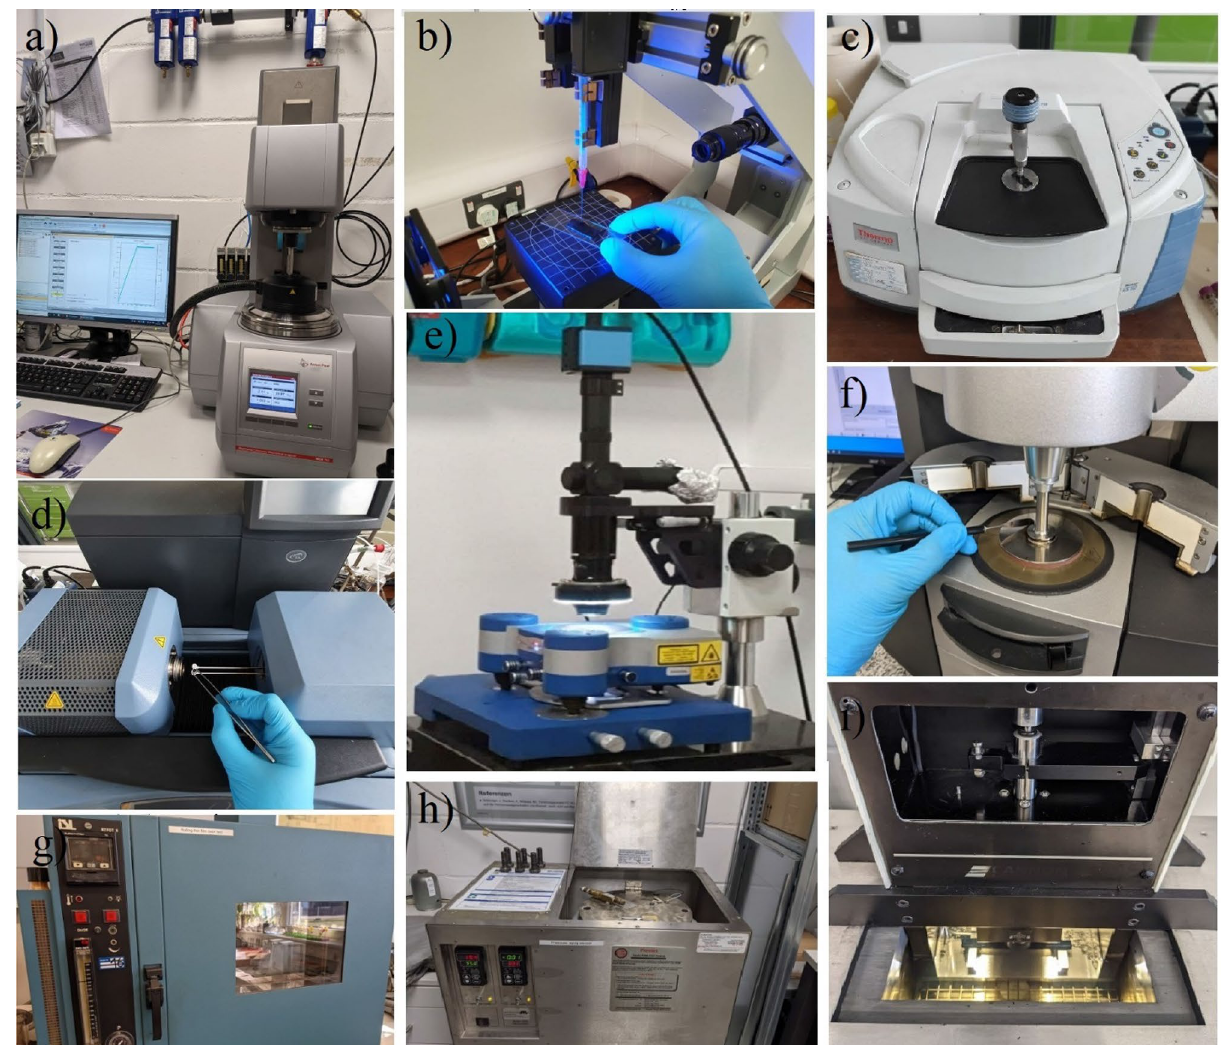
Figure 12. Devices used in the study: ( a ) rotational rheometer, ( b ) drop shape analyzer, ( c ) Fourier transform infrared spectroscopy, ( d ) thermal gravimetric analysis, ( e ) atomic force microscopy, ( f ) dynamic shear rheometer, ( g ) rolling thin-film oven, ( h ) pressure aging vessel, and ( i ) bending beam